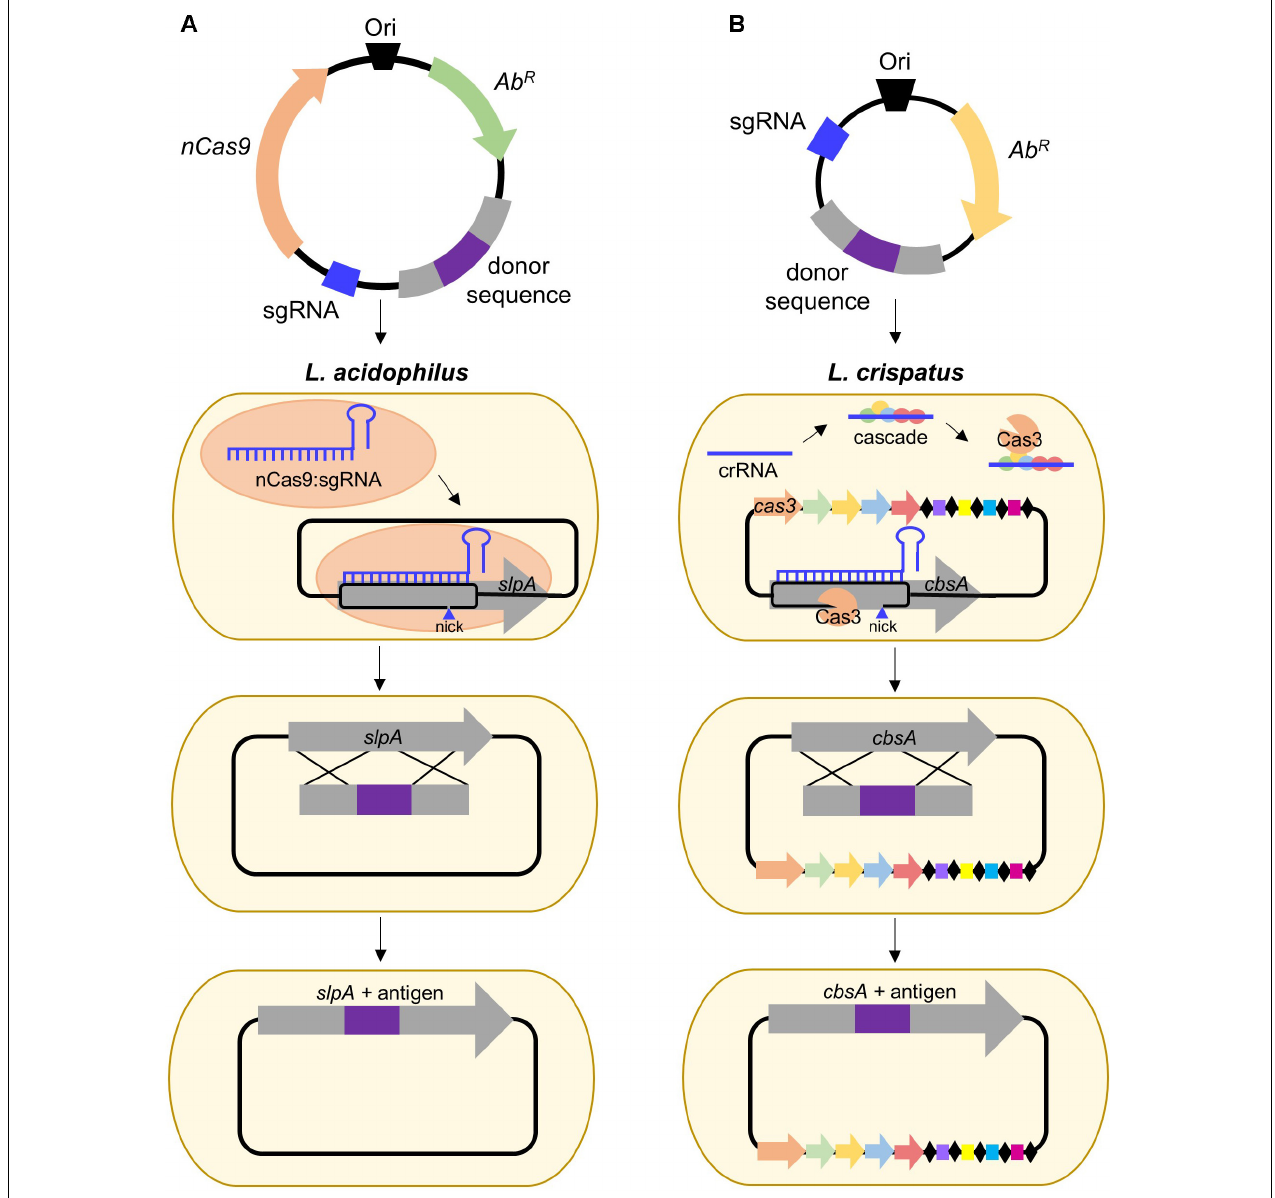
FIGURE 2 | Proposed strategies for CRISPR-based genome editing in relevant S-layer-forming lactobacilli. (A) Antigen integration into L. acidophilus SlpA via an exogenous Type II system employing a Cas9 nickase variant which introduces a guide RNA-targeted single-stranded break. Unlike wild-type Cas9 which generates blunt double-stranded breaks (DSB), nickases cut only one strand of the DNA, permitting genome editing in bacteria deficient in DSB repair (Chiang et al., 2016; Song et al., 2017). (B) Antigen integration into L. crispatus CbsA using the endogenous Type I system which consists of the CRISPR-associated complex for antiviral defense (Cascade) and the signature Cas3 nuclease (Barrangou,